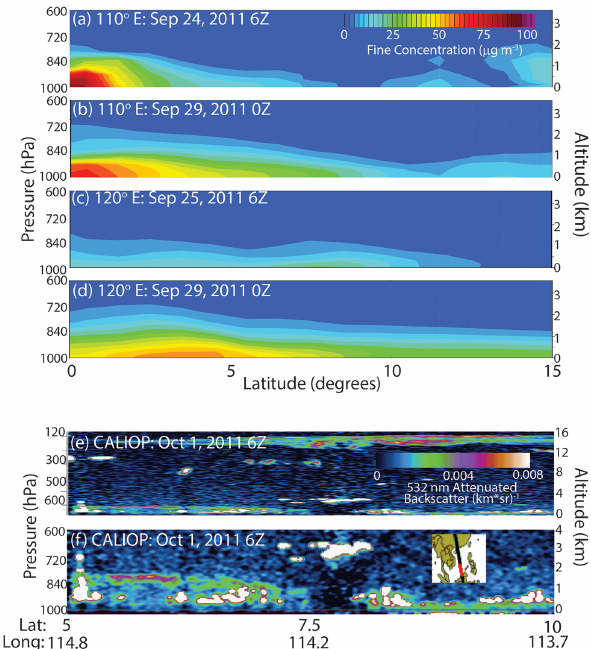
Figure 5. NAAPS 550nm aerosol optical thickness (AOT) and sur- face concentrations for fine mode anthropogenic and biomass burn- ing particle concentrations for 4 key days during the cruise. Satellite data for these 4 days is also presented in Fig. 3. Cross sectional lines for Fig. 6 (24 and 30 September) are placed on the AOT plot.